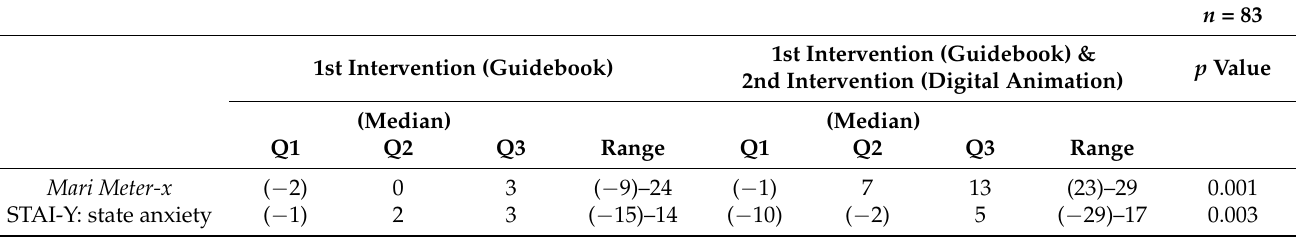
Table 4. Outcomes for the 1st intervention vs. the 1st intervention & 2nd